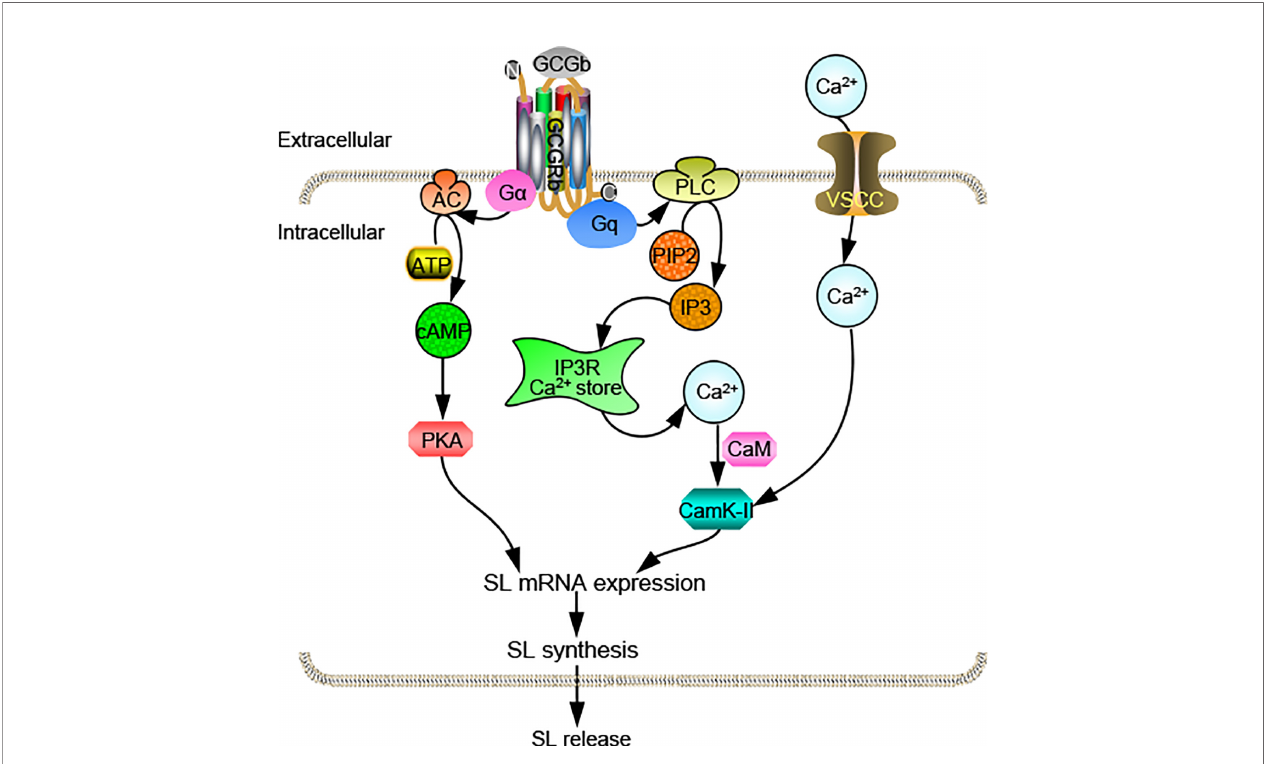
FIGURE 9 | Working model of SL regulation by GCGb induction in tilapia NIL cells. GCGRb activation by GCGb can up-regulate SL release and gene expression via stimulation of the AC/cAMP/PKA and PLC/IP3/Ca 2+ /CaM/CaMK-II